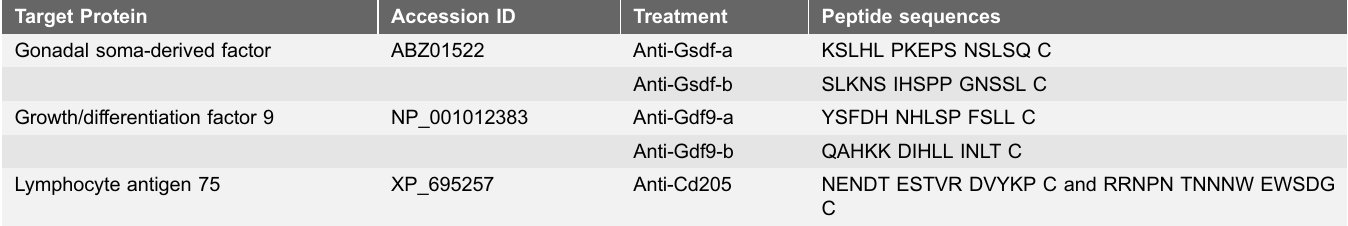
Table 4. Target peptide sequences used as antigens for immunization in the juvenile zebrafish trial.